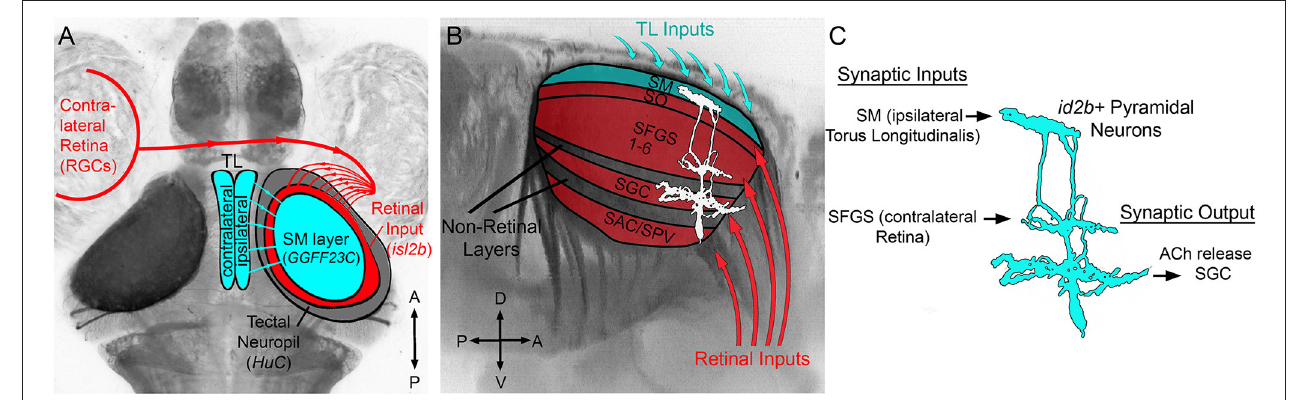
FIGURE 1 | Overview of TL-tectum circuit and PyrN connectivity. (A) Dorsal view fluorescence image of a Tg( HuC:lynTagRFP-t) larval brain in which all axon tracts and neuropil areas are fluorescently labeled, with superimposed schematic of the brain regions examined in this study. Connectivity of TL-tectum circuitry: ipsilateral TL forms an axonal projection terminating in the SM layer of the tectal neuropil. The contralateral retina forms an axonal projection terminating in tectal layers distinct from SM. (B) Higher magnification side view of the midbrain of brain volume in (A) . Overlayed schematic depicts the relative laminar positions of retinal input layers relative to SM, other non-retinorecipient neuropil layers, and PyrN stratification pattern. (C) Putative connectivity of id2b:gal4 positive PyrNs. Based on laminar position of dendrites PyrNs most likely receive TL-derived inputs on their SM dendrite and retinal inputs on their SFGS dendrite. PyrN axon stratifies within the SGC